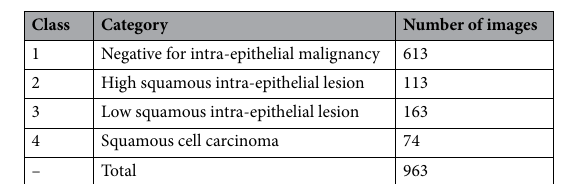
Figure 9. Examples of images from the Mendeley LBC dataset 18 . HSIL high squamous intra-epithelial lesion, LSIL low squamous intra-epithelial lesion, NIL negative for intra-epithelial lesion, SCC squamous cell carcinoma.